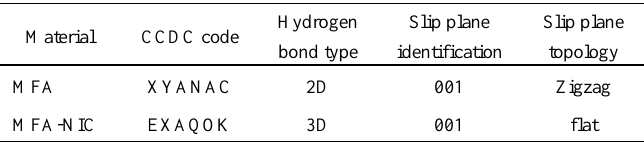
Fig. 5. The crystal packing and zigzag shape of MFA slip plane (red line). Table 1. Identification of slip plane using